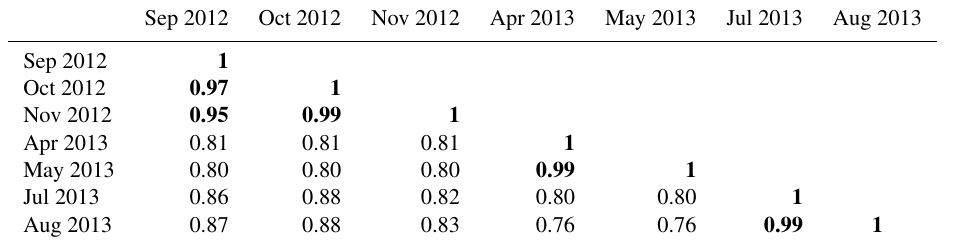
Table 4. Spearman rank correlation coefficients ( r s ) between spatial patterns of soil moisture ( θ d,25 ) in the intermediate soil horizon. Values of r s ≥ 0.9 are highlighted in bold.